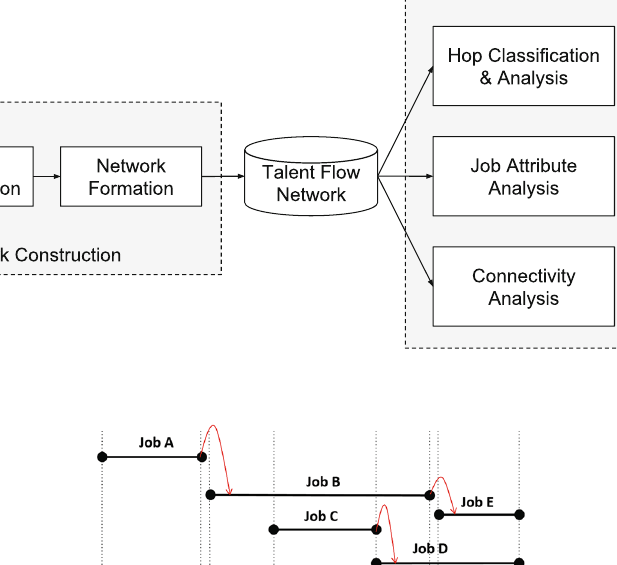
Fig. 1 Overview of the proposed talent flow analytics framework